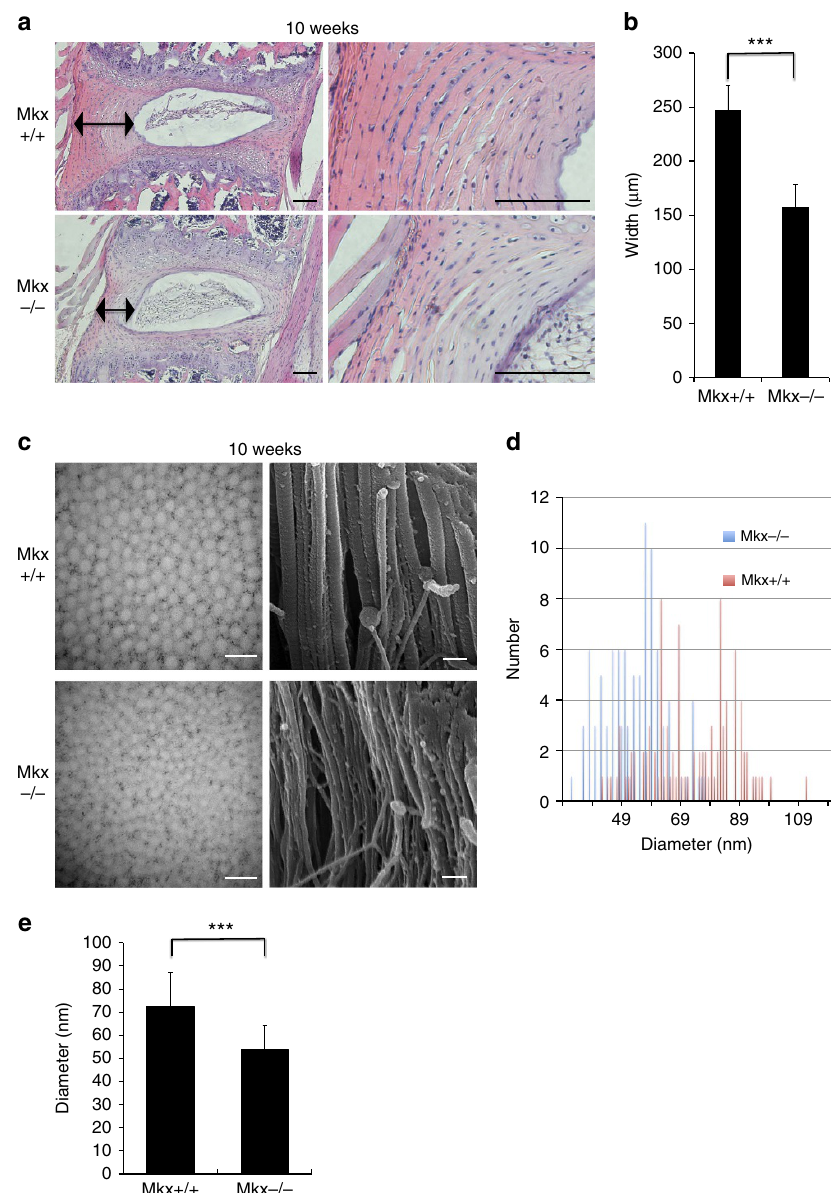
Figure 2 | Multiscale analyses of the annulus fibrosus (AF) from Mkx (cid:2) / (cid:2) mice. ( a ) Haematoxylin–eosin staining of IVDs of 10-week-old Mkx þ / þ and Mkx (cid:2) / (cid:2) mice. Black arrow, width of the AF. Scale bars, 300 m m. ( b ) Width of the AF from 10-week-old Mkx þ / þ versus Mkx (cid:2) / (cid:2) mice. For Mkx þ / þ , mean width ¼ 246.9 m m (s.d. ¼ 23.04 m m). For Mkx (cid:2) / (cid:2) , mean width ¼ 157.5 m m (s.d. ¼ 21.16 m m). ( c ) Images of transmission electron microscopy (left column) and scanning electron microscopy (right column) of the OAF of 10-week-old Mkx þ / þ and Mkx (cid:2) / (cid:2) mice. Scale bars, 200nm. ( d ) Histogram of the diameter of collagen fibrils from 10-week-old Mkx þ / þ and Mkx (cid:2) / (cid:2) mice. Blue bar, Mkx (cid:2) / (cid:2) ; red bar, Mkx þ / þ . ( e ) The calculated mean of the diameter of 100 collagen fibrils from 10-week-old Mkx þ / þ and Mkx (cid:2) / (cid:2) mice. For Mkx þ / þ , mean diameter ¼ 72.73nm (s.d. ¼ 14.5nm). For Mkx (cid:2) / (cid:2) , mean diameter ¼ 53.99nm (s.d. ¼ 10.31nm). Error bars represent the s.d. *** P o 0.001. Statistical differences were assessed with Student’s t